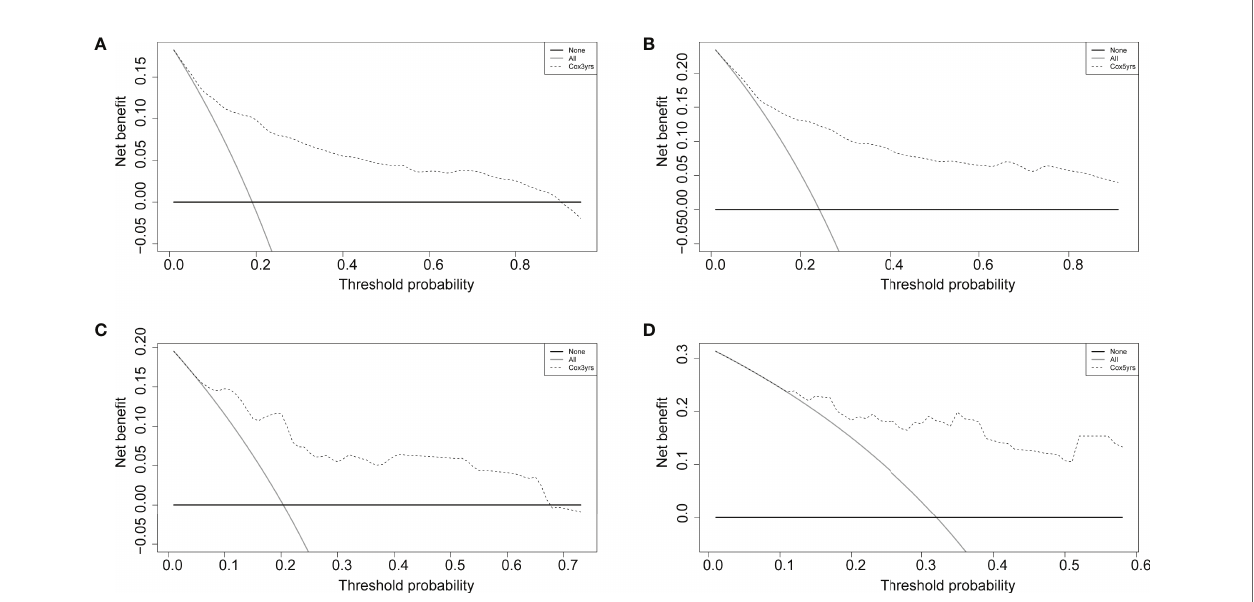
FIGURE 5 | Decision curves of the nomogram comparison for the training (A, B) and validation (C, D) cohorts at 3 and 5 years. The solid black horizontal line represents no interventions triggered for all patients, the gray line represents all interventions triggered, and the dashed line is for the predictive model-guided trigger of medical